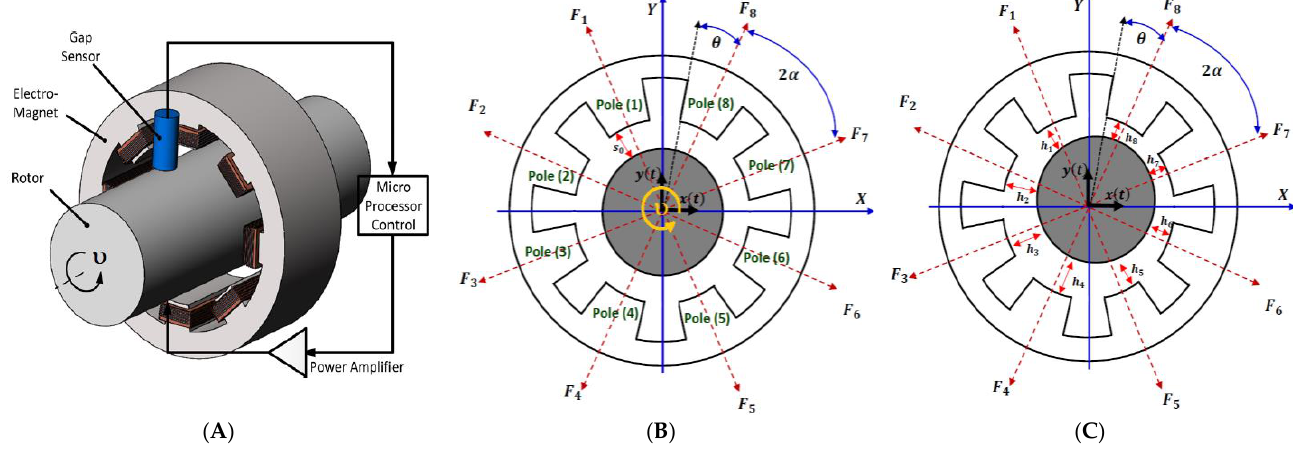
Figure 1. 8-pole rotor active magnetic bearing system: ( A ) basic working principle of the active magnetic bearing system, ( B ) the rotor system in its nominal position with air-gap size 𝑠 0 , and ( C ) the rotor system with small deviation and dynamic air-gap size ℎ 𝑗 , 𝑗 = 1,2,… ,8 .